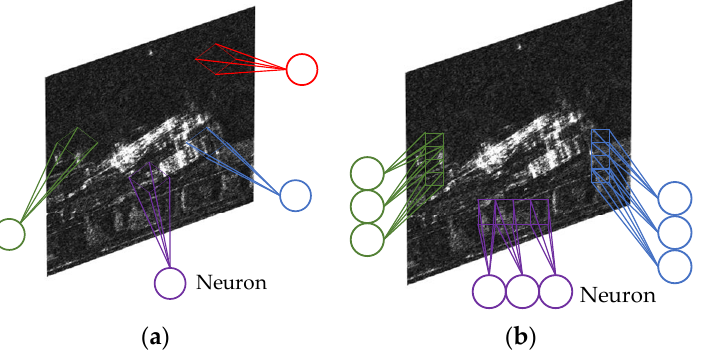
Figure 5. Locally connected network and weight sharing: ( a ) Locally connected network; ( b ) Weight sharing.